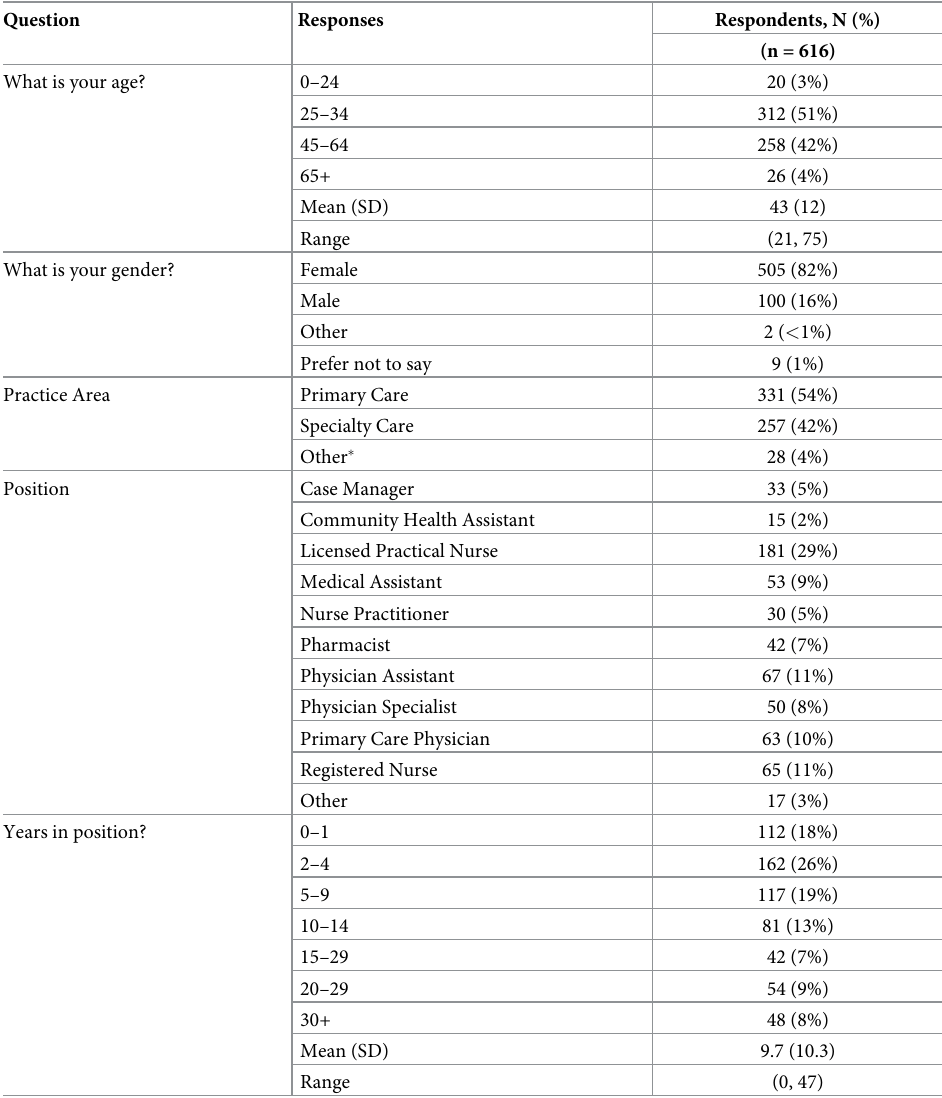
Table 1. Staff survey